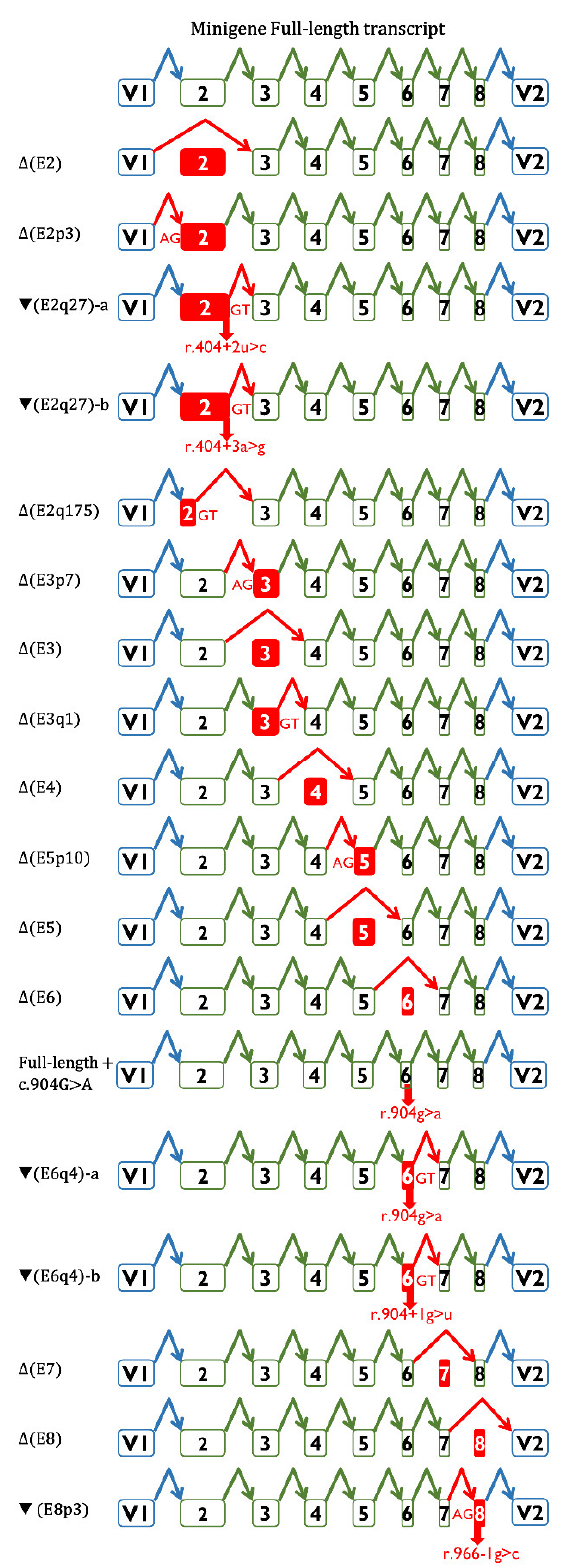
Figure 3. Splicing isoforms generated by RAD51C variants. Diagrams of the splicing reactions. Exons and the splicing reactions are indicated by boxes and elbow arrows, respectively. Anomalous events and exons are indicated in red.